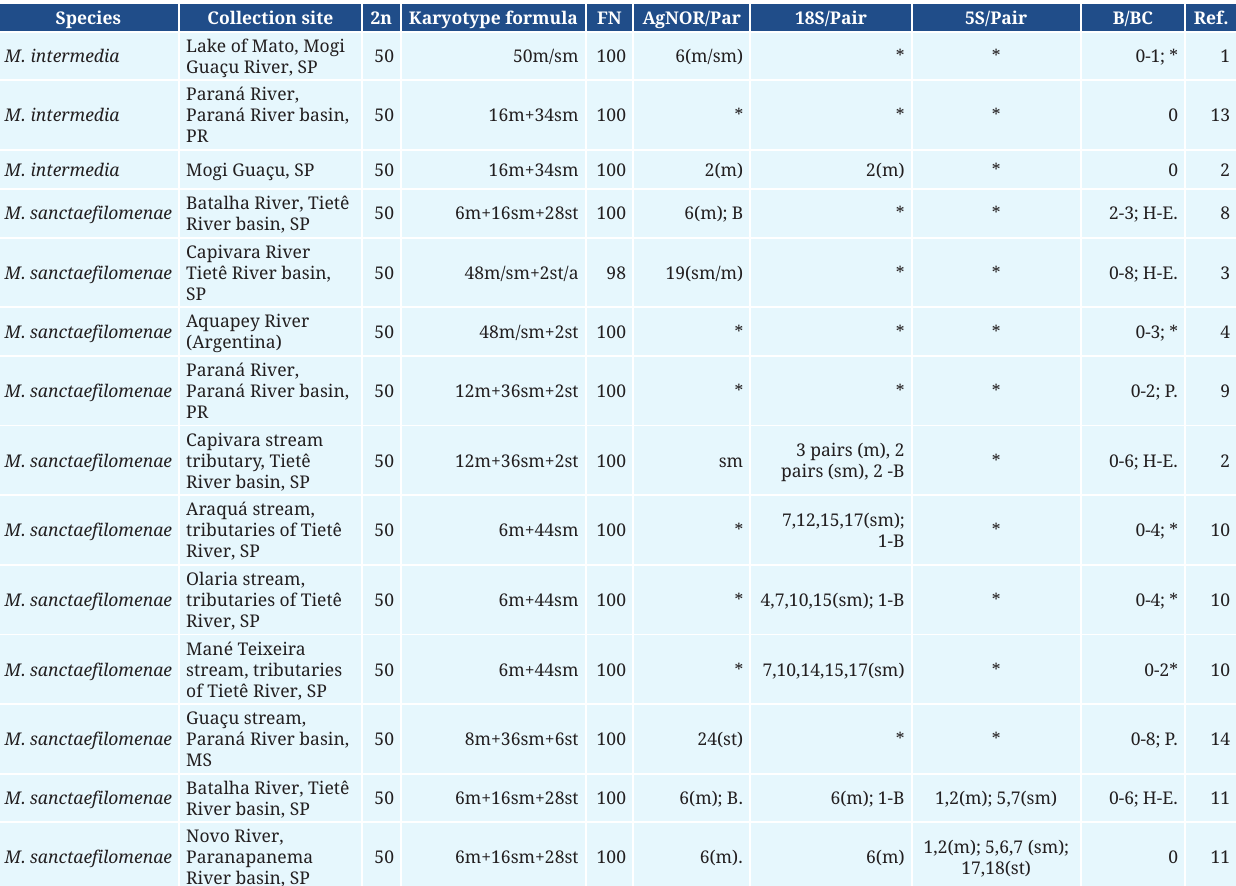
TABLE 1 | Review of cytogenetic data in Moenkhausia . Abbreviations: m = metacentric; sb = submetacentric; st = subtelocentric; a = acrocentric; FN = fundamental number; cyt = cytotype; B = B chromosome; 5S = 5S rDNA, 18S = 18S rDNA; NOR = AgNOR; Ref =